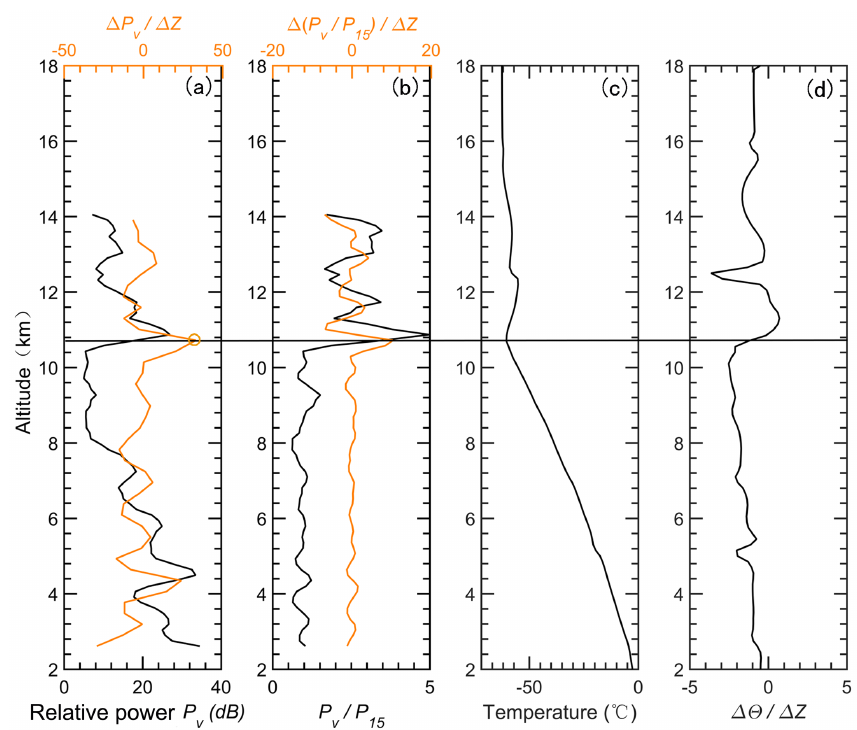
Figure 1. Example of the vertical height profiles of (a) the relative radar echo power (black line, smoothed by a three-point running mean) along with its gradient variation (orange line), (b) the aspect sensitivity (black line, expressed as the ratio between the vertical echo power and oblique echo power) along with its gradient variation (orange line), observed on 12:00UT 29 November 2014. The vertical profiles of simultaneous radiosonde-observed temperature and potential temperature gradient are shown in plots (c) and (d) . The black horizontal line denotes the LRT height derived from the radiosonde temperature profile. The orange circle indicates the RT height derived from the profile of the radar backscattered echo power.